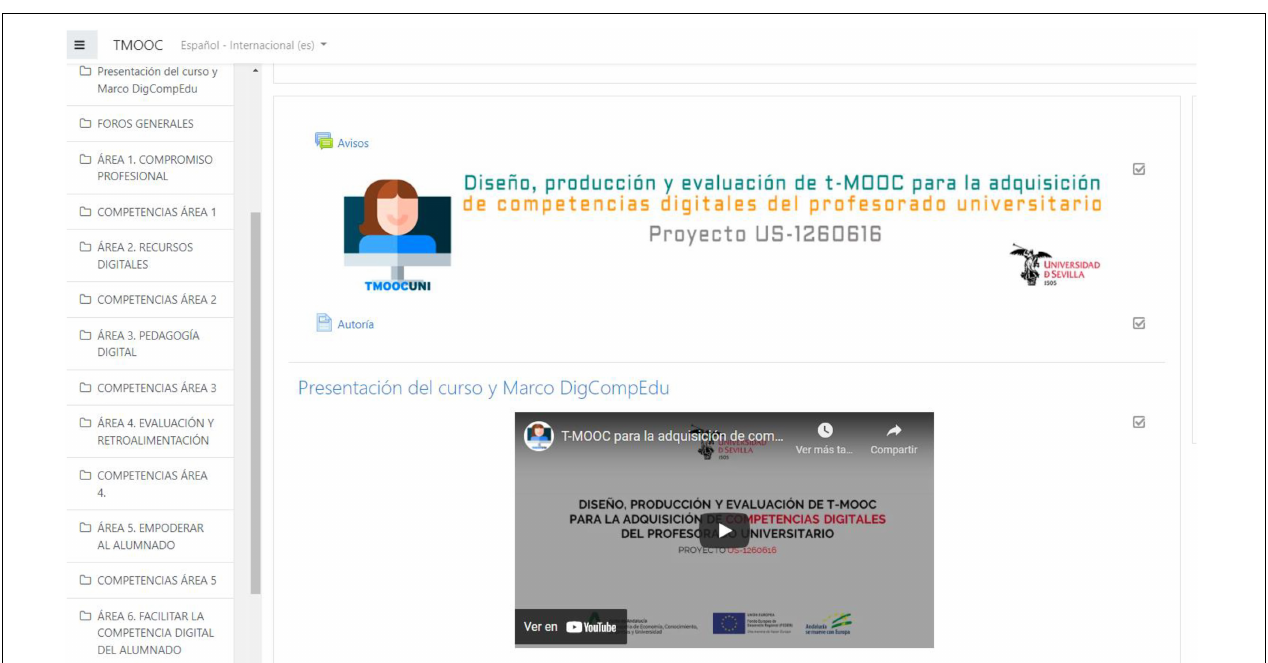
FIGURE 2 | Transfer massive open online courses for the acquisition of digital teaching competencies.